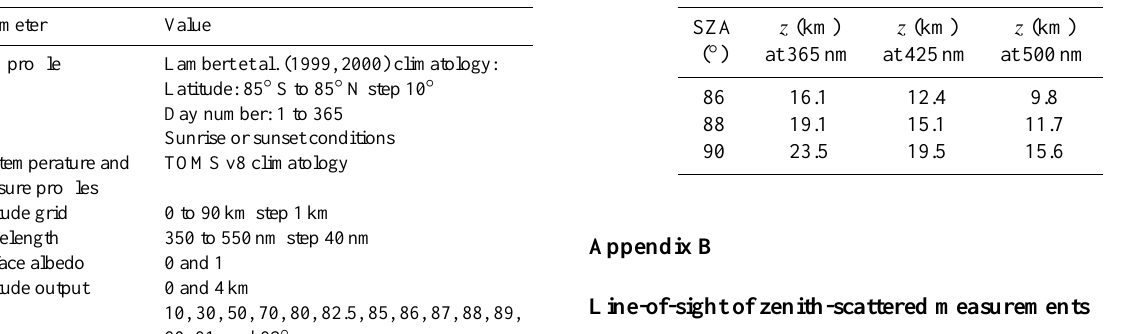
Table A1. Parameters used to initialize the UVSPEC/DISORT ra- diative transfer model for the calculation of the NO 2 AMF LUTs.